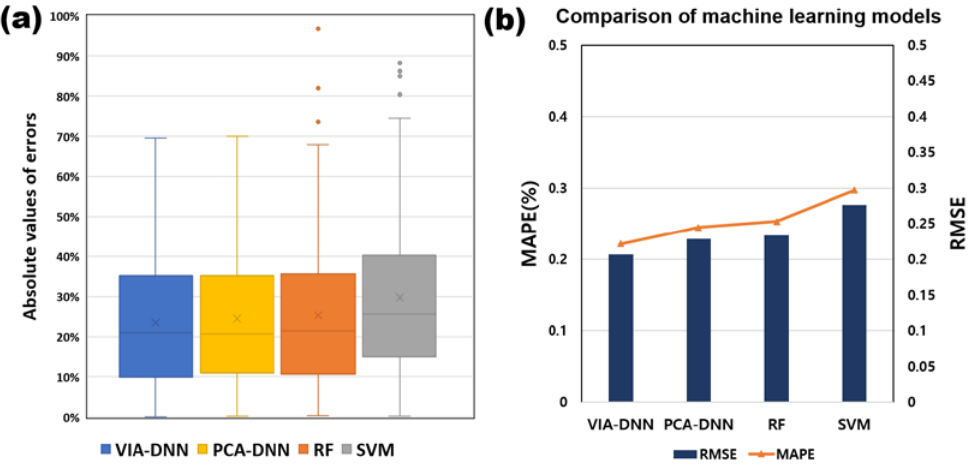
Figure 16. Comparison of predictive performance for CGP prediction supervised learning models. ( a ) absolute error; ( b ) RMSE and MAPE.